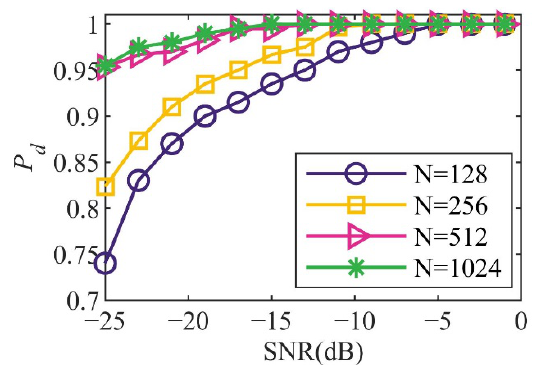
Figure 7. Effect of sampling points.